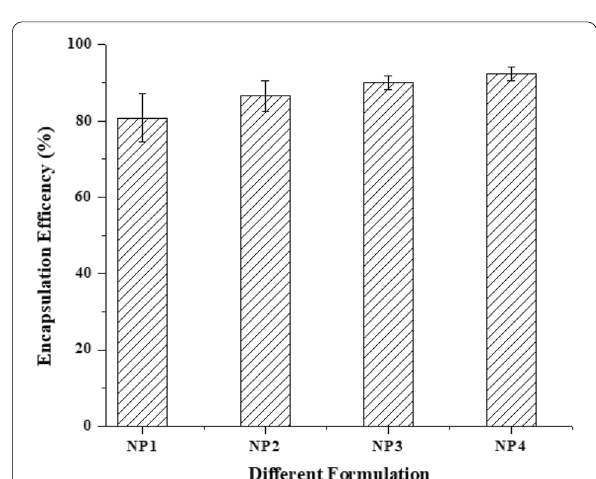
Fig. 2 The encapsulation efficiency of BSA encapsulated into four different nanoparticles formulation NP1, NP2, NP3 and NP4 with 0.5, 1.0, 1.5, 2.0 mg/ml concentration of